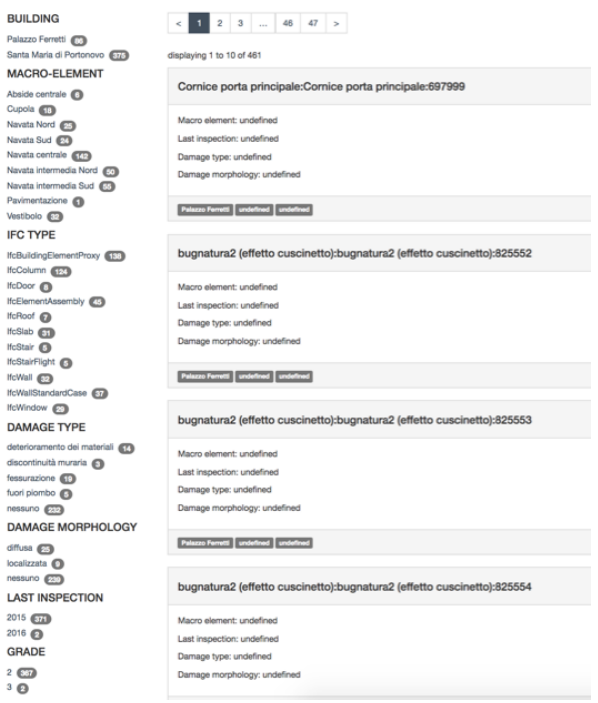
Figure 9. The faceted browser showing all the available